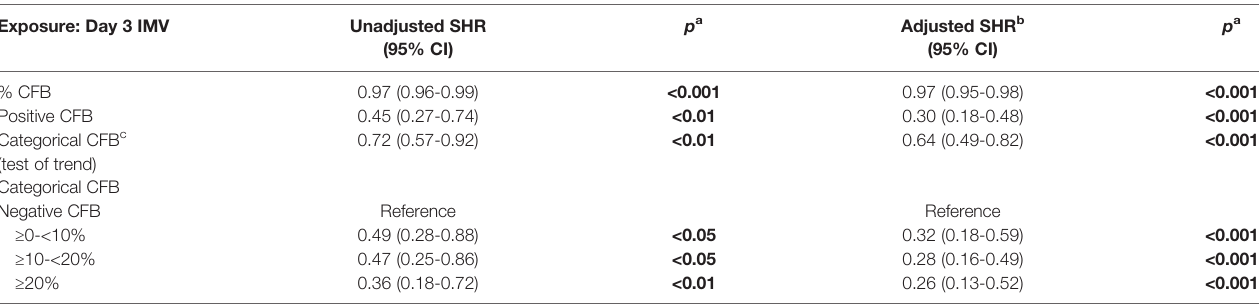
TABLE 3 | Association between day 3 cumulative fl uid balance and rate of extubation (28 days). Exposure: Day 3 IMV